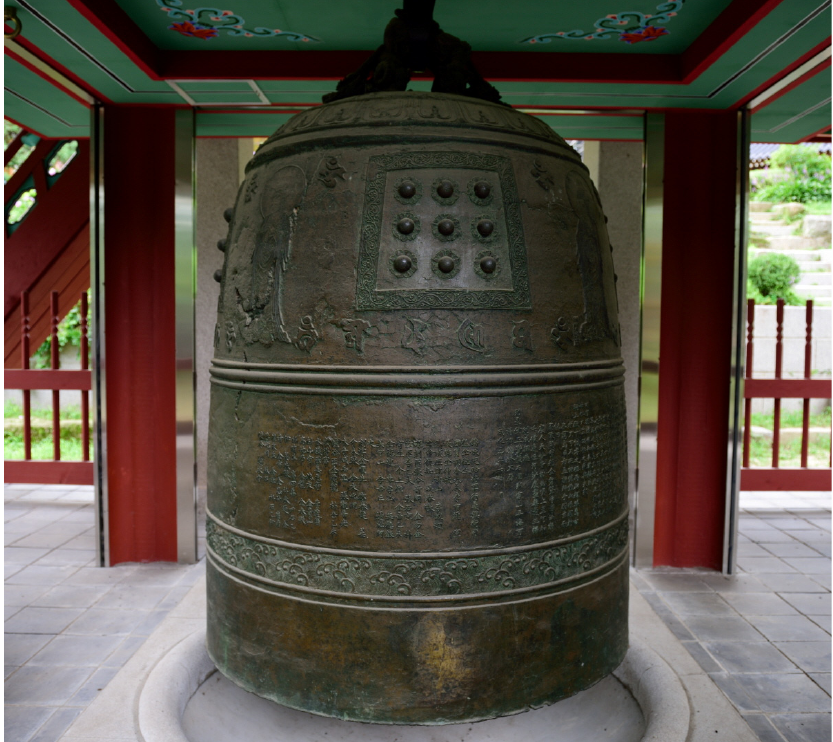
Figure 19. Pongs ŏ nsa Bell. Chos ŏ n dynasty, dated 1469. H. 236.0 cm. Pongs ŏ nsa, Namyangju, Figure 19. Pongsŏnsa Bell. Chosŏn dynasty, dated 1469. H. 236.0 cm. Pongsŏnsa, Namyangju, Ky ŏ nggi Province of Korea. Kyŏnggi Province of